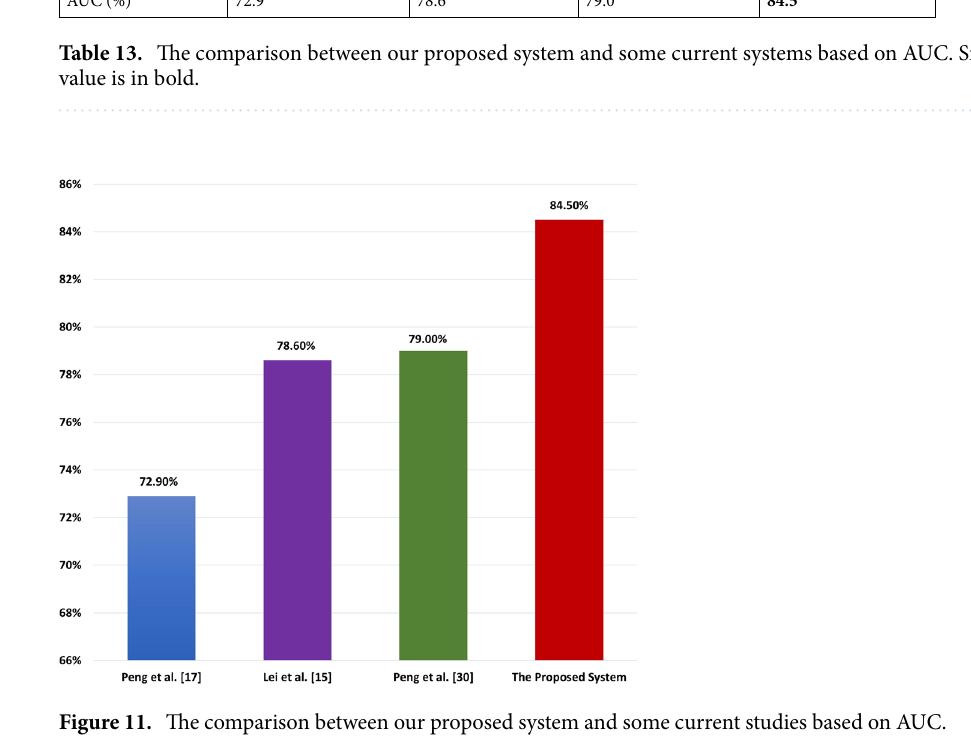
PD. Figure 11 represents the comparison chart among the AUC of our proposed prediction system and other prediction systems.